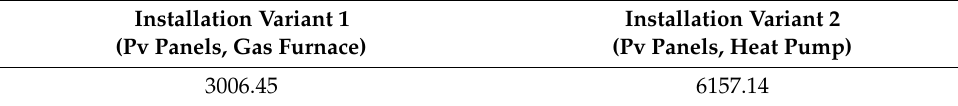
Table 2. The total electricity for analysed installations options